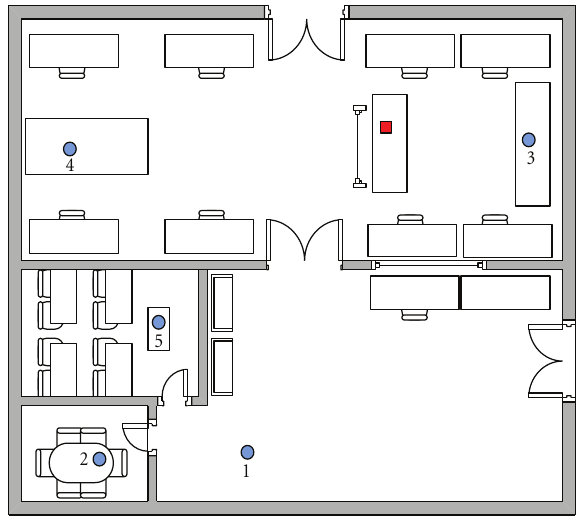
Figure 1: Map of a measured